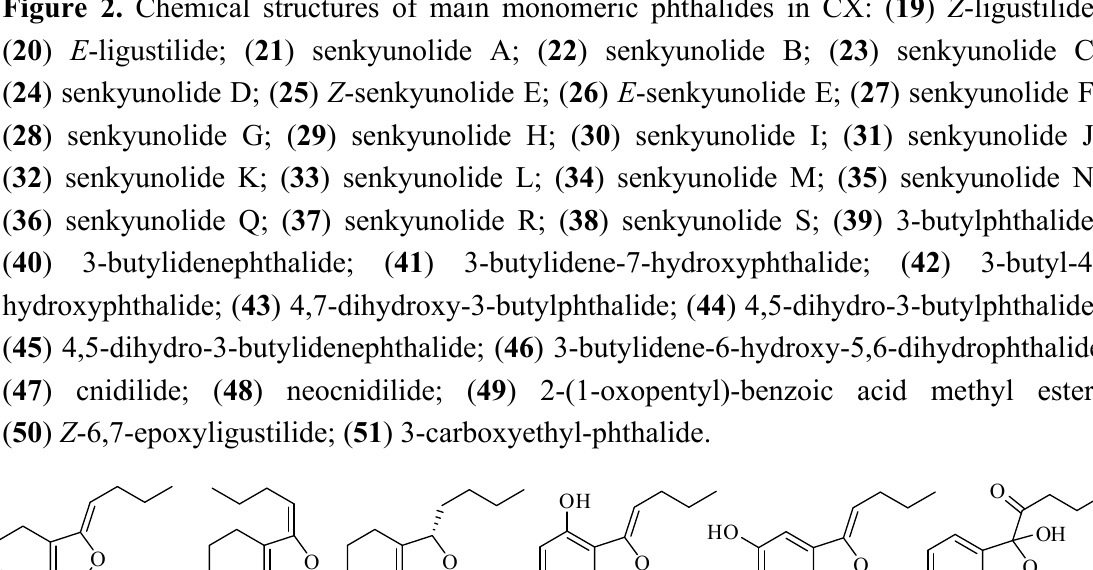
Figure 2. Chemical structures of main monomeric phthalides in CX: ( 19 ) Z